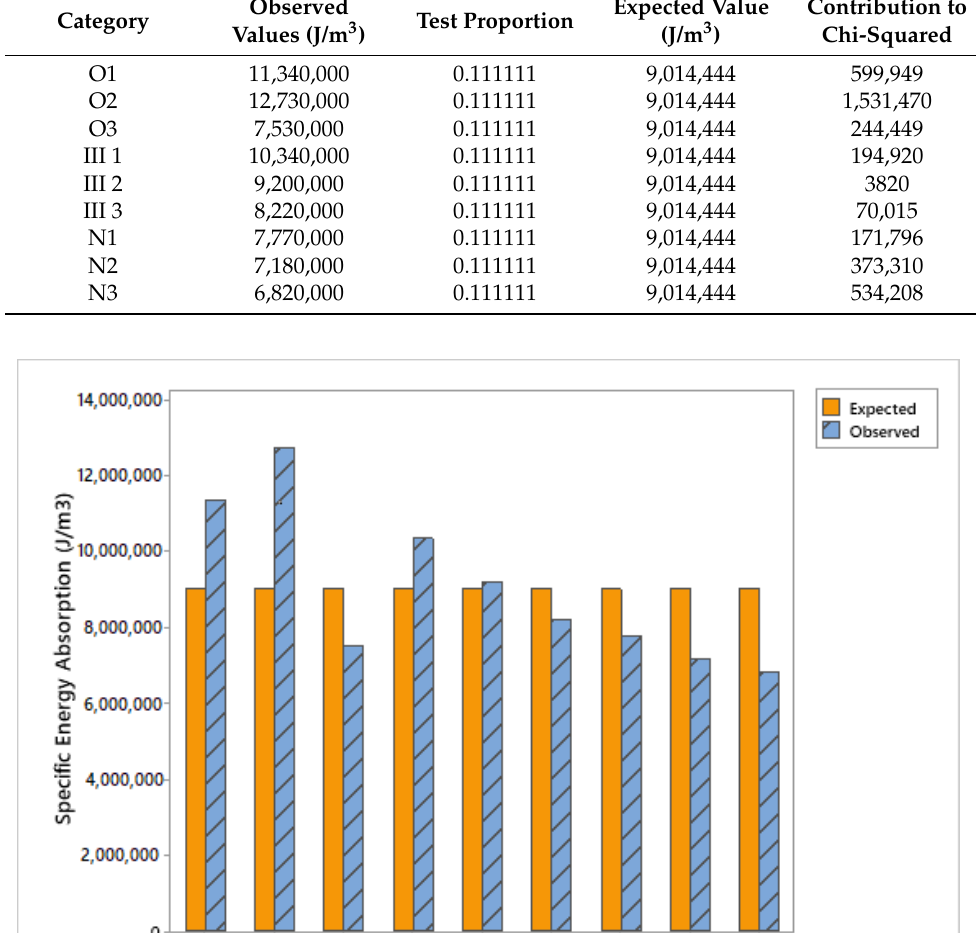
Table 3. Observed and expected values of specific energy absorption for samples.